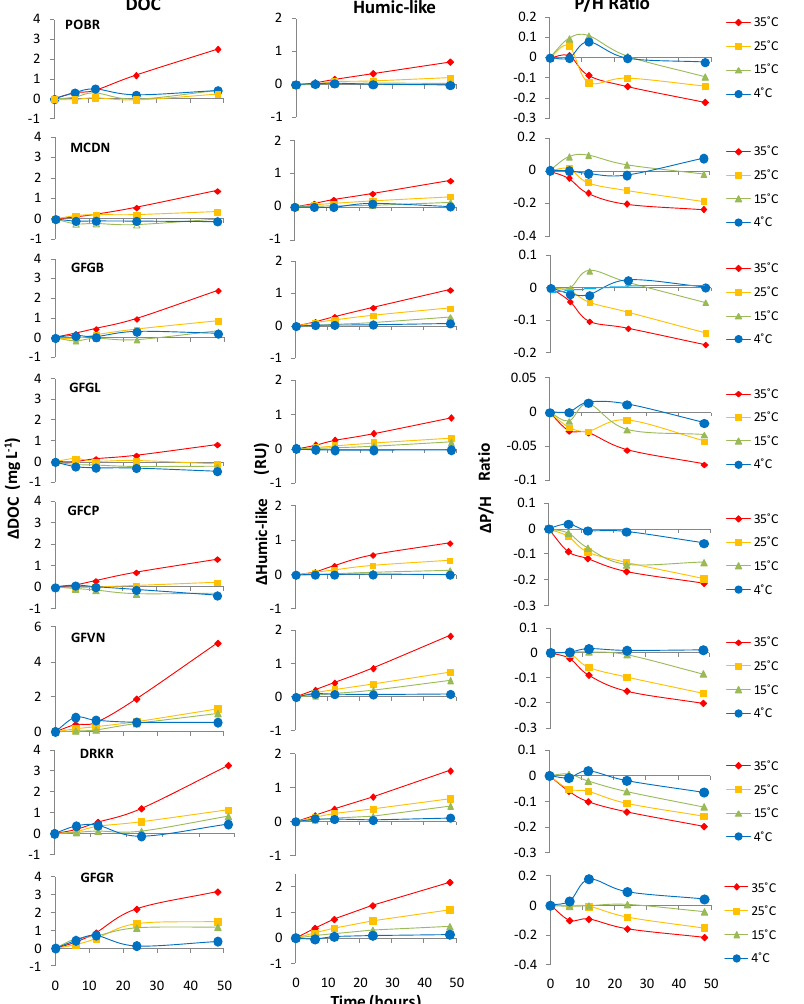
Fig. 3. Changes in DOC concentration, humic-like fluorescence (in Raman Unit, or RU) and protein to humic ratio (P/H ratio) during the 48-h sediment incubations, relative to initial values before incubation. Humic-like fluorescence is in Raman Unit (RU).